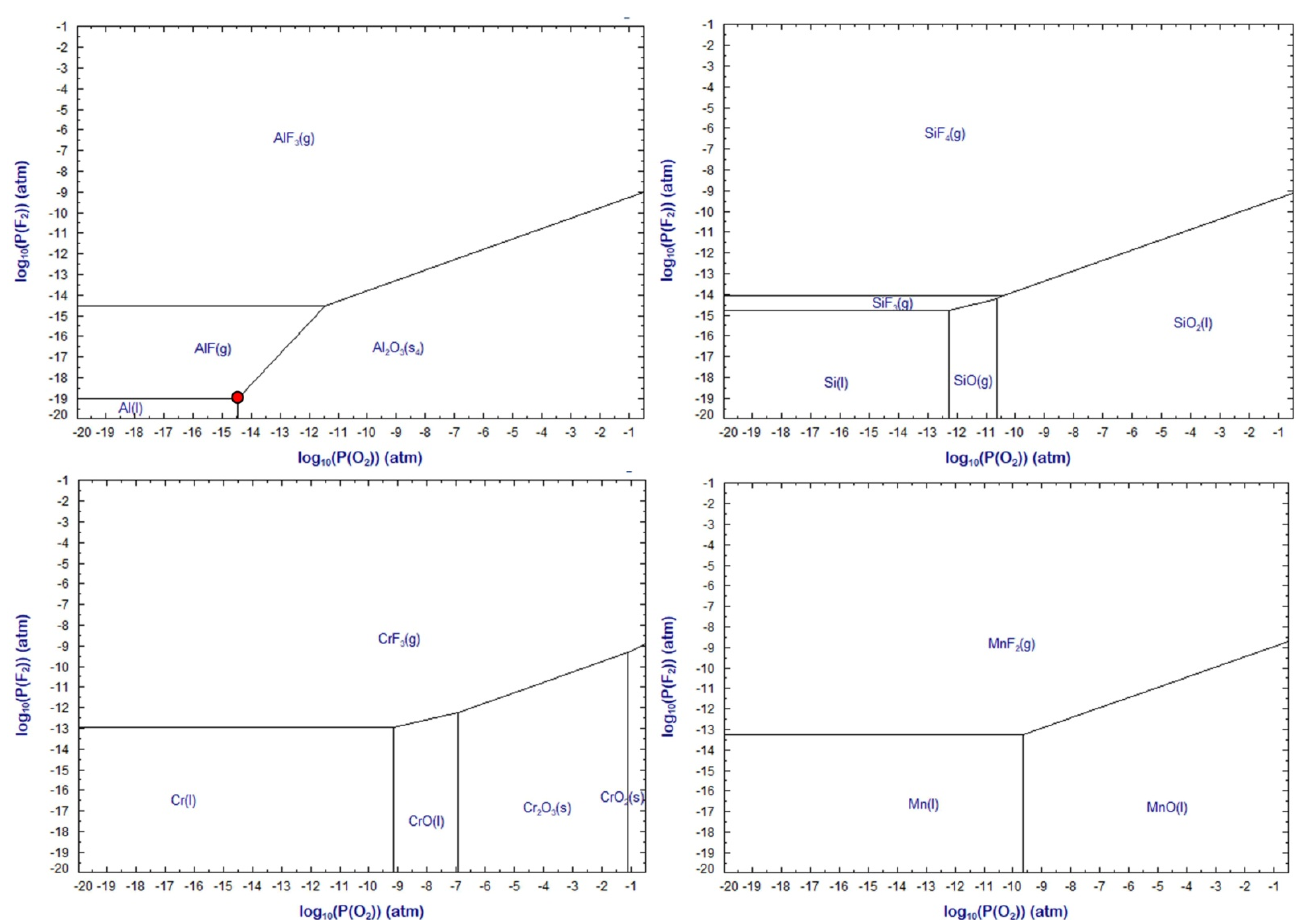
Figure 18. Predominance diagrams in M-O-F at 2000 °C (M = Al, Cr, Fe, Mn, Si).